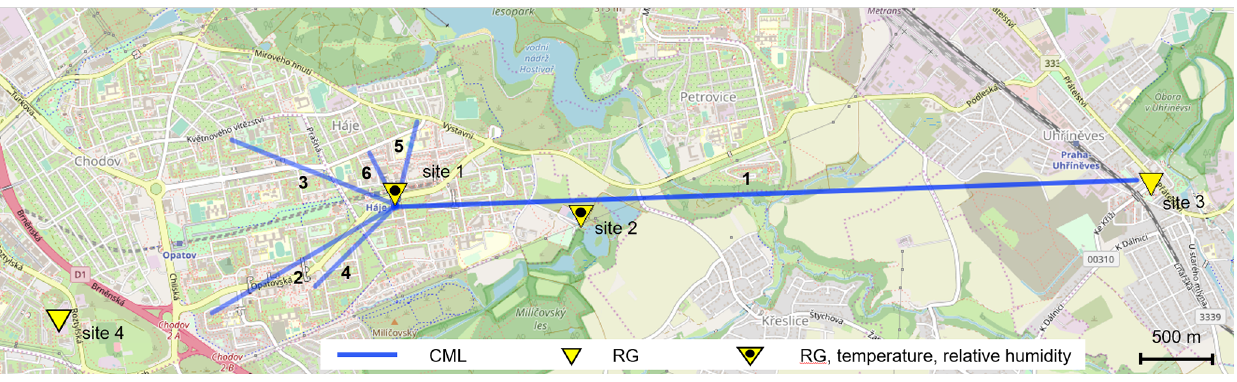
Figure 2. Case study area Prague-Haje, Czech Republic. Two of the rain gauges are equipped with air humidity and temperature probes. © OpenStreetMap contributors. Distributed under a Creative Commons BY-SA